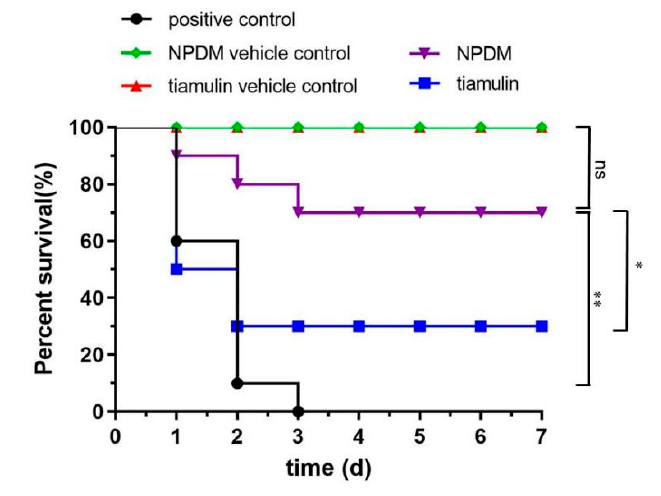
Figure 6. Survival of mice challenged with MRSA ATCC 43300 after treatment with 30 mg/kg body weight of NPDM ( n = 10). NPDM vs. NPDM vehicle control, ns ; NPDM vs. positive control, **; NPDM vs. tiamulin, *. ( ns , not significant; * 0.01 < p < 0.05; ** 0.001 < p < 0.01).